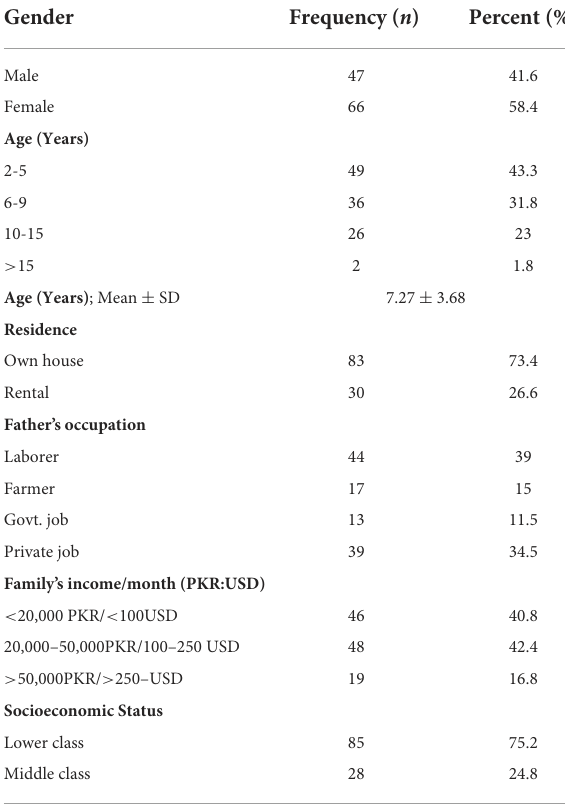
TABLE 1 Demographic profile of patients with celiac disease (CD). TABLE 2 Anthropometric measurements of patients with celiac